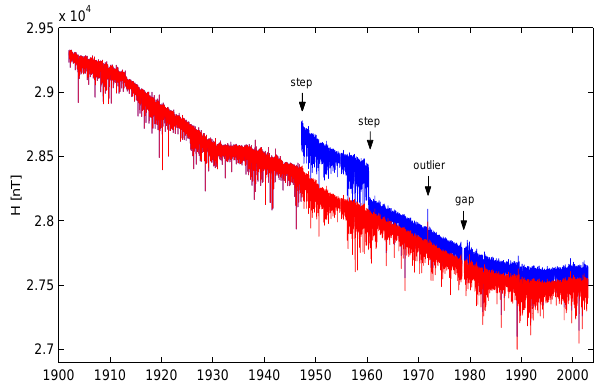
Fig. 1. The H component at HON before (blue) and after (red) re- moving the two steps at 1 April 1947 and 1 May 1960. One outlying data point during 1971 was removed from the data. The gap during 1978 was filled.